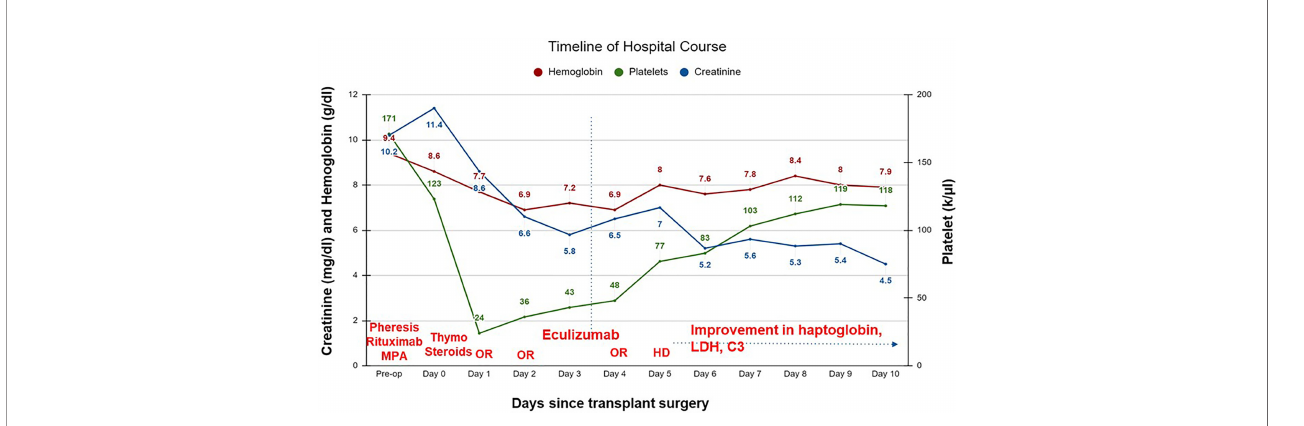
FIGURE 1 | Timeline of hospital course of patient after a living unrelated kidney transplantation. C3, complement 3; HD, hemodialysis; LDH, lactate dehydrogenase; OR, operative room; thymo, thymoglobulin; MPA,